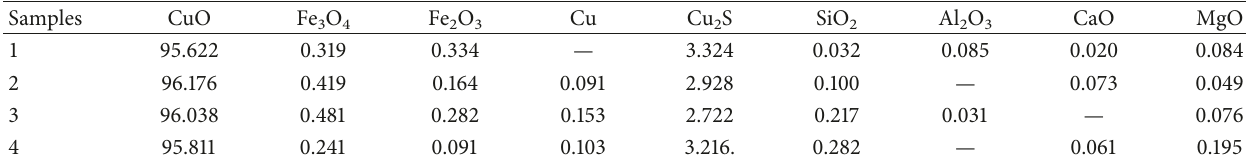
Table 3: The determination results by XRF (%).